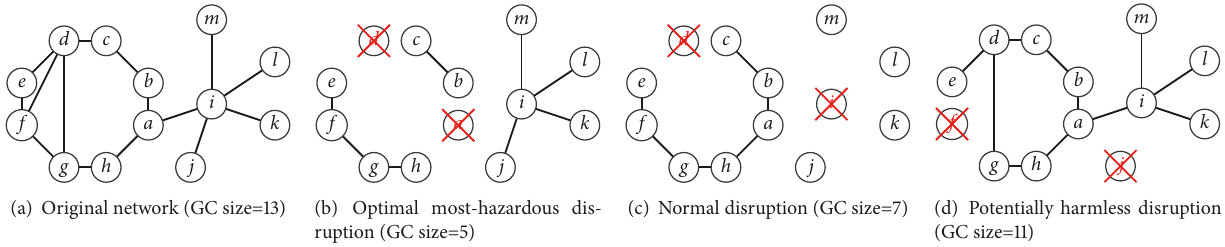
Figure 2: An example of a network attack. The process starts with a target network (a), where we want to attack two nodes. In (b) we show an optimal disruption when being allowed to disrupt two nodes. The choice of 𝑎 and 𝑑 reduces the GC size from 13 to 5 . In (c) we show a disruption induced by node failures of 𝑑 and 𝑖 . In (d) we show a disruption induced by node failures of 𝑓 and 𝑗 ; the majority of the network is still functional, as the GC size is reduced from 13 to 11